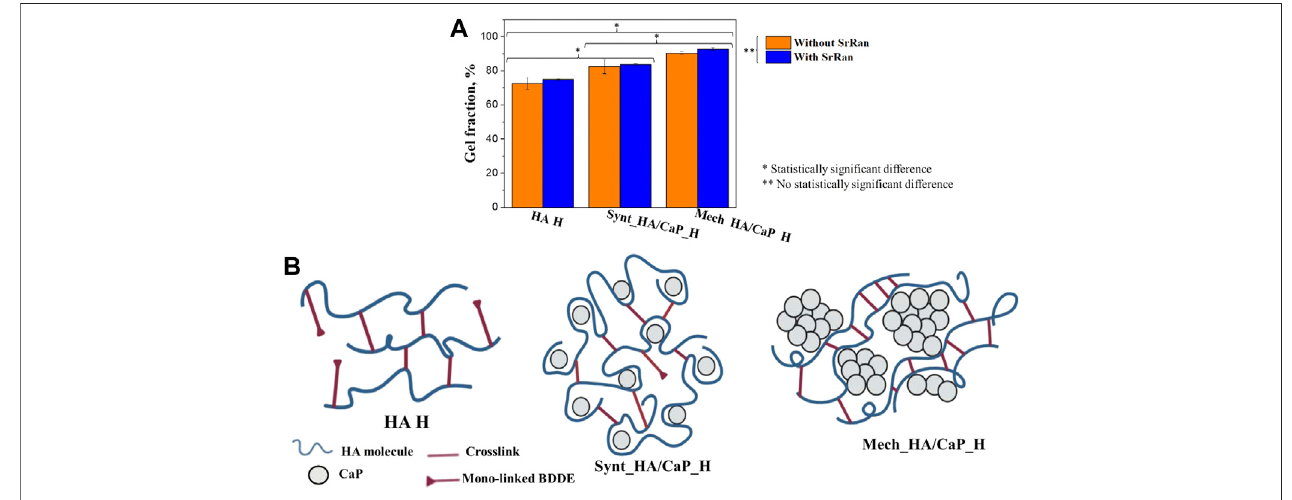
FIGURE 5 | In fl uence of CaP addition on the crosslinking degree of hyaluronic acid-containing hydrogels: (A) gel fraction of HA-containing composites; (B) schematic illustration of possible crosslink formation in HA-containing